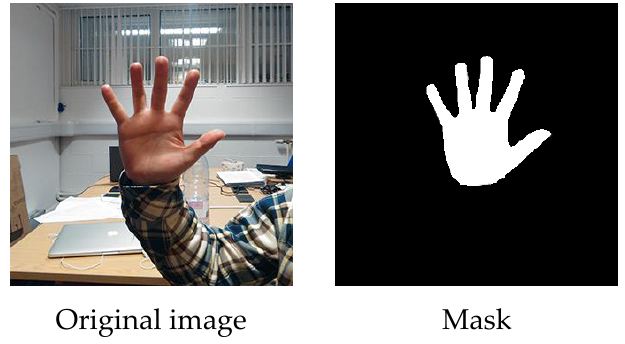
Figure 4. The mask.